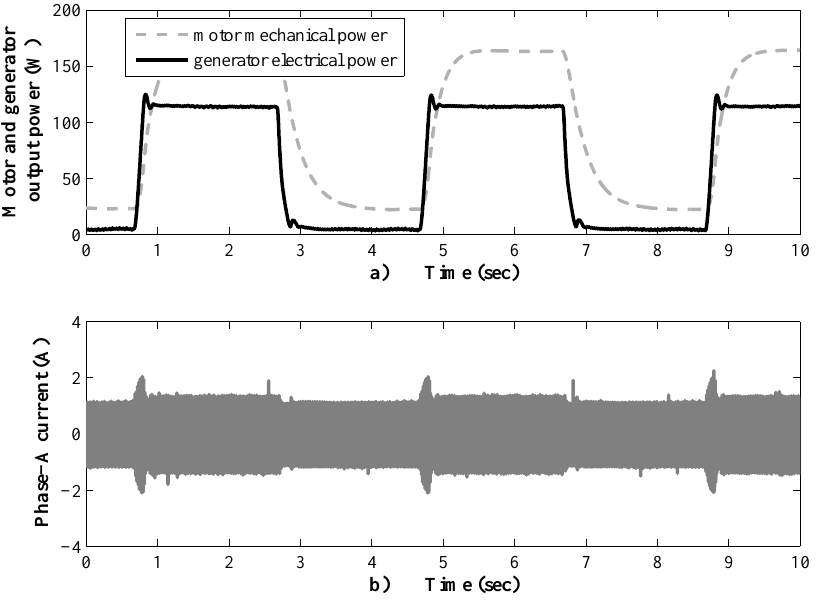
Figure 8. SOSM controller: ( a ) Motor and generator output powers, and ( b ) phase- A